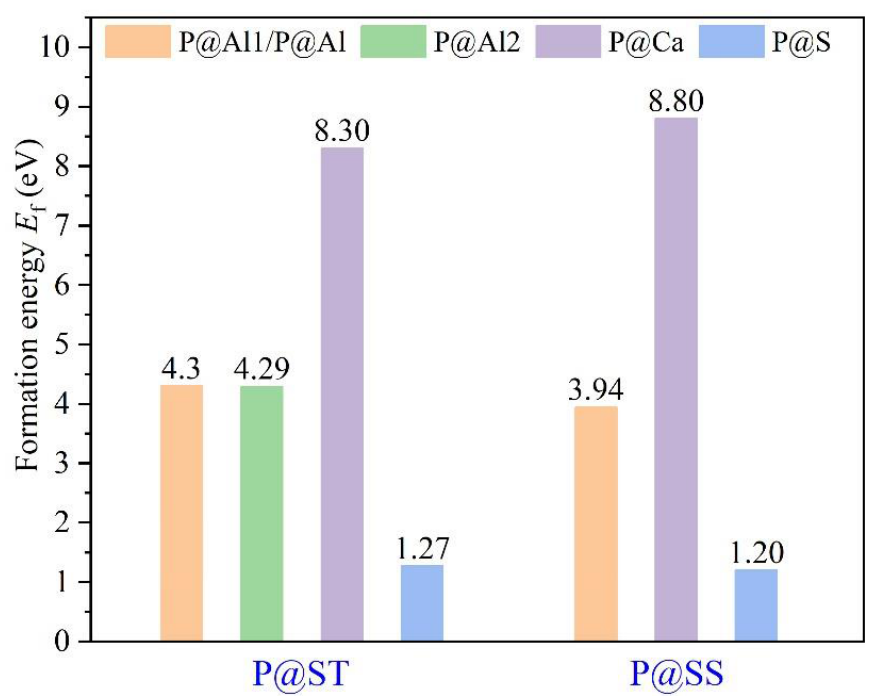
Figure 7. Crystalline structures of cubic ye’elimite and the doped models (2 × 1 × 1), ( a ) pure, ( b ) P@S, ( c ) P@Ca, and ( d ) P@Al.